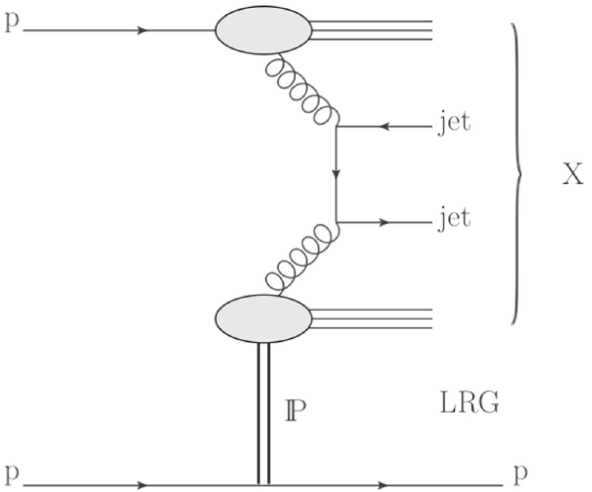
Fig. 1 Schematic diagram of single-diffractive dijet production. The exchange of a virtual object with the vacuum quantum numbers (i.e. a Pomeron) is indicated by the symbol IP. The diagram shows an example of the gg → dijet hard scattering process; the qq and gq initial states also